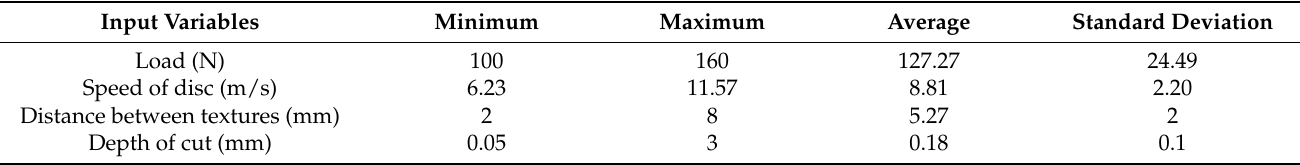
Table 2. Input parameters for the ANN